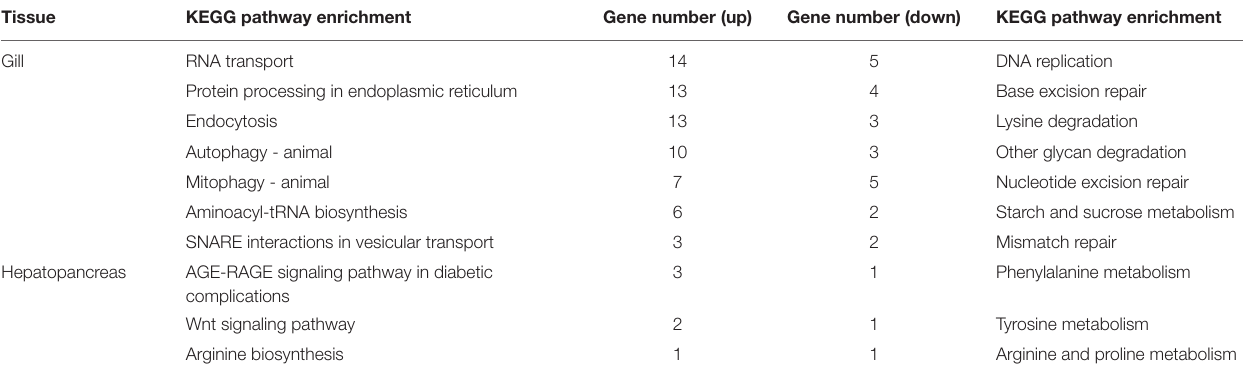
TABLE 4 | Kyoto Encyclopedia of Genes and Genomes (KEGG) enrichment of differentially expressed genes (DEGs) in the gill and hepatopancreas of S . constricta under ammonia exposure. Tissue KEGG pathway enrichment Gene number (up) Gene number